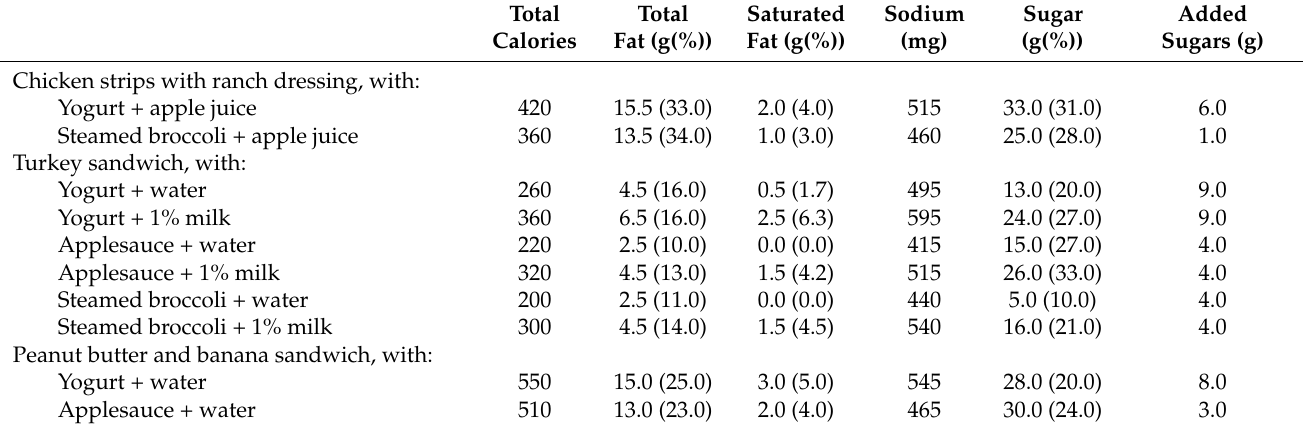
Table 3. Kids’ meal combinations meeting Kids LiveWell guidelines (i.e., ≤ 550 cal, ≤ 10% saturated fat, ≤ 700 mg sodium, ≤ 15g added sugars, 0 g trans-fat) a